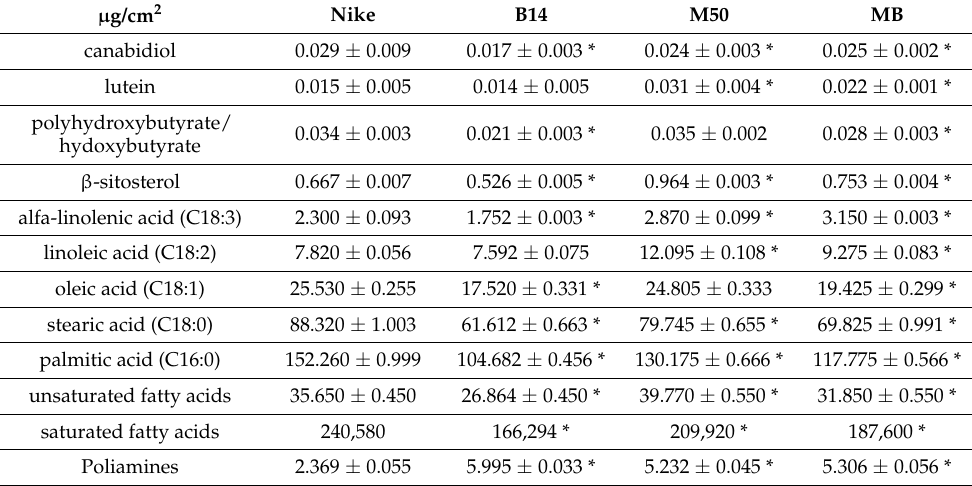
Table 2. Content of other bioactive compounds per cm 2 of fabric—the measurement was made after the sterilization (average of 5–6 independent samples obtained from different parts of the fabric). The statistical significance of the differences between the results for the tested linen fabrics compared to the control was calculated using the Tukey post hoc test (* p < 0.05). µ g/cm